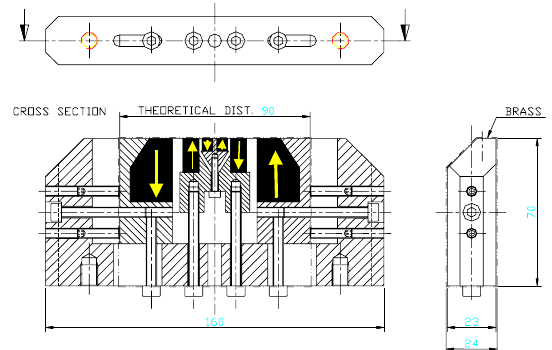
FIG. 9. (Color) The bottom half of the magic fingers attached to the ends of the wiggler. The yellow arrows indicate polarity of permanent magnets. Dimensions in